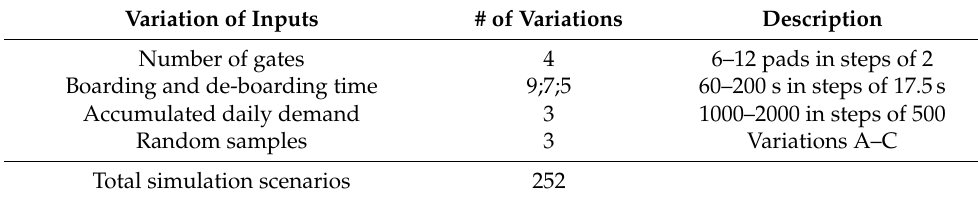
Table 4. Study design for gate-related drivers of